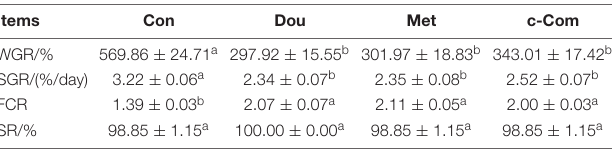
TABLE 2 | Growth performance of juvenile Songpu mirror carp fed different diets.